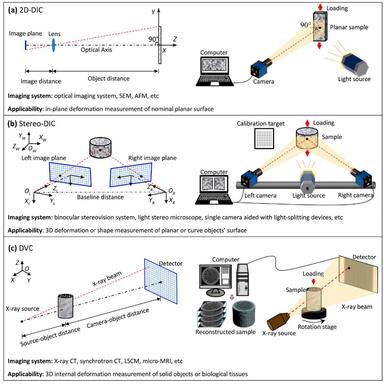
Three typical digital image correlation (DIC) techniques and their imaging diagrams. (a) 2D-DIC, (b) stereo-DIC, and (c) digital volume correlation (DVC) . Herein SEM refers to scanning electron microscope , AFM refers to atomic force microscope , CT refers to computed tomography, and LSCM refers to laser scanning confocal microscope . The copyright permission for this figure has been granted.